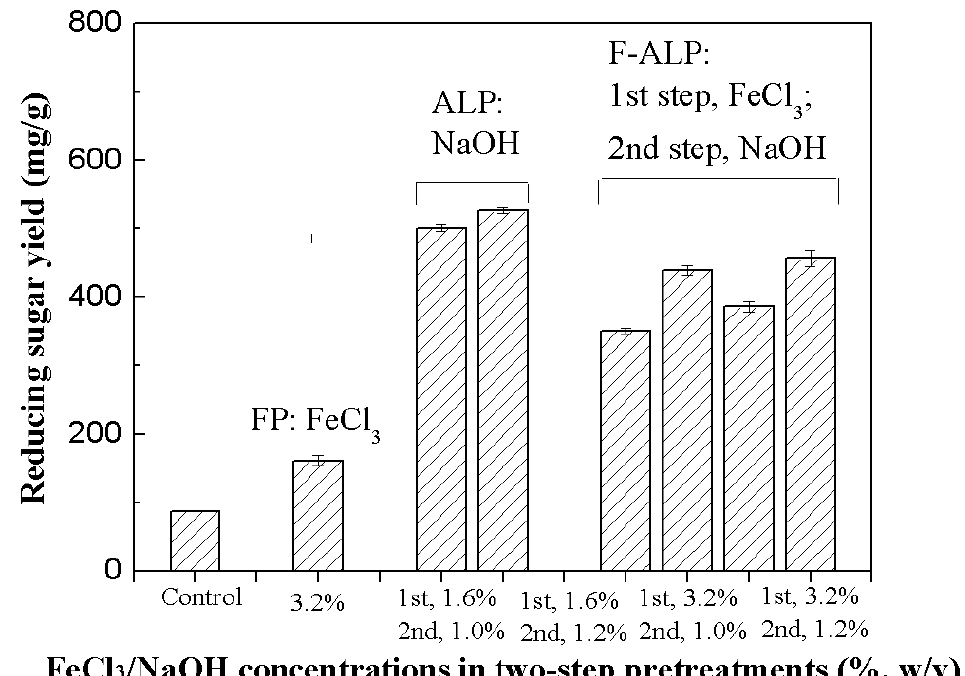
Figure 3. Enzymatic hydrolysis of the ferric chloride and dilute alkaline pretreatment (F-ALP) samples.